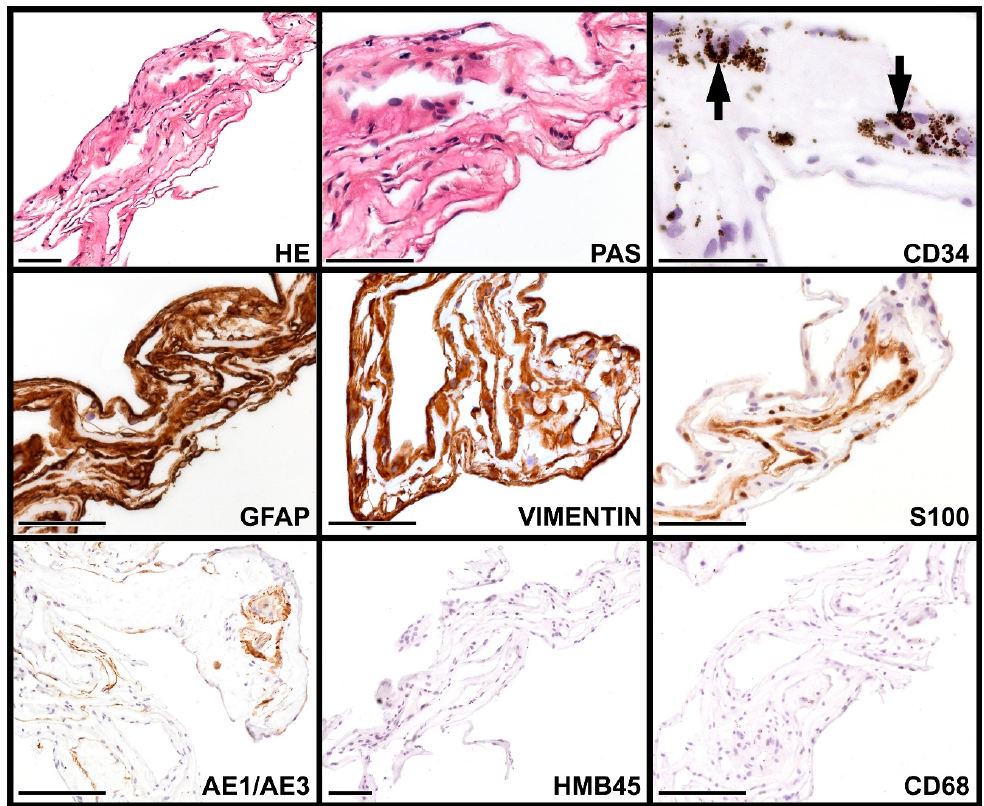
Figure 2. Histological and immunohistochemical features of vitreous membrane. Thin, membrane-like tissue was observed, composed of scattered cells embedded in an eosinophilic, slightly periodic acid-Schiff (PAS)-positive substance. The cells had small rounded or elongated nuclei without atypia, scanty cytoplasm, and indistinct cell borders (hematoxylin and eosin (H&E)). The cells did not rest on basement membrane (PAS). Occasionally, brownish-black pigment granules were observed in a few cells (arrows) and in the adjacent extracellular substance, shown in the cluster of differentiation 34 (CD34)-stained part. The cytoplasm of the cells and the extracellular substance strongly and diffusely reacted with GFAP and vimentin; the S-100 staining decorated the majority of nuclei and occasionally the extracellular substance. Focal cytoplasmic and extracellular substance positivity for anti-pan cytokeratin antibody (AE/AE3) and smooth muscle-specific actin (SMA; not shown) was noted. The human melanoma black-45 (HMB-45), cluster of differentiation 68 (CD68), cytokeratin 18 (CK18), cytokeratin 19 (CK19), and cluster of differentiation 34 (CD34) reactions were negative. Scale bars: 100 µm.